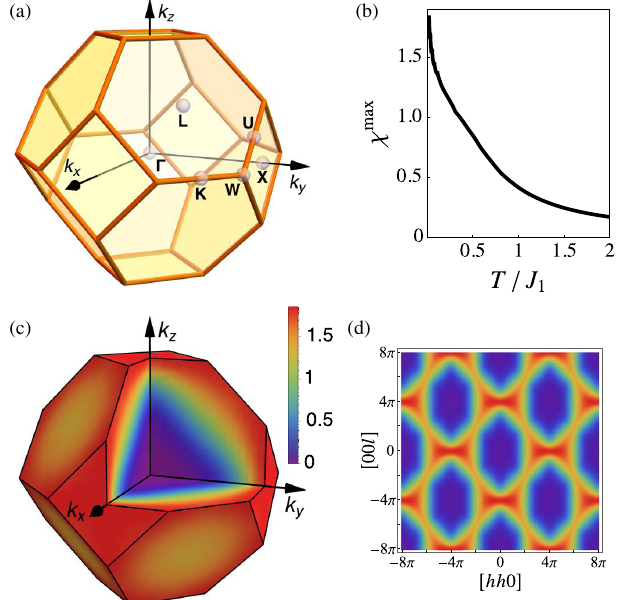
FIG. 5. (a) The EBZ (a truncated octahedron) of the pyrochlore lattice labeled with the high-symmetry points. (b) – (d) For the S ¼ 1 = 2 isotropic nearest-neighbor Heisenberg antiferromagnet, the RG flow of the susceptibility evaluated at the W point (b), the k -space-resolved magnetic susceptibility profiles (in units of 1 =J T=J 1 = 100 and shown in the EBZ (c) and 1 ) evaluated at 1 ¼ projected onto the ½ hhl (cid:2) plane